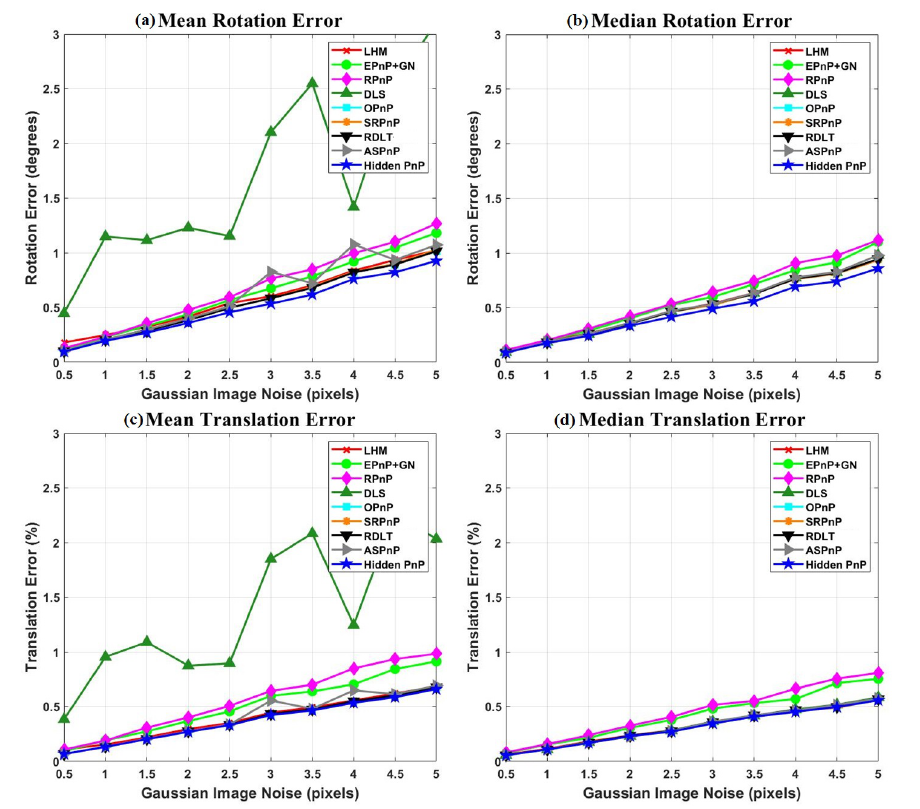
Figure 6. Error comparison in ordinary 3D